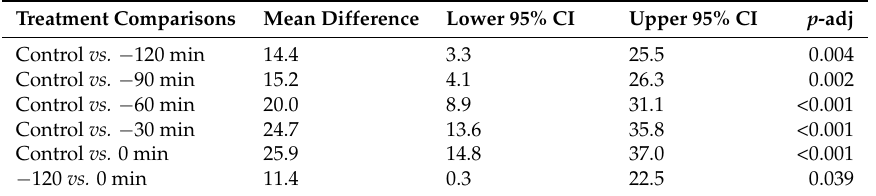
Figure 2. Skin lotion repellency against Vespula vulgaris tested under field conditions. ( A ) Heat-maps of the total numbers of vespids in function of time, for three surfaces (control, treated at t = − 120 min and t = 0). The X-axis represents the replicated experiments, the Y-axis the number of vespids counted at each min, following the colored scale bar ( below ). ( B ) Box-and-whisker plots of the overall numbers of time counts without flying and feeding vespids, for each one of the six surfaces: (Ctrl) control, ( − 120 to 0) min. Table 1. Statistical comparisons between vespid-free times on an untreated control surface and on five surfaces treated at different times.